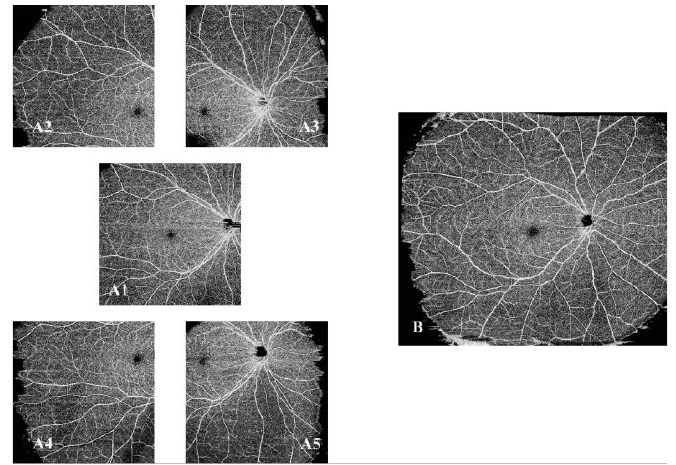
Figure 2. Swept source optical coherence tomography angiography (SS-OCTA) images of the right eye. ( A1 – A5 ) SS-OCTA images of 12 mm × 12 mm scanning mode in different regions. ( A1 ) Macula- centered. ( A2 ) Superior temporal. ( A3 ) Superior nasal. ( A4 ) Inferior temporal. ( A5 ) Inferior nasal. ( B ). The composite image of ( A1 – A5 ) with an area of 23.5 mm × 17.5 mm. SS-OCTA, swept-source optical coherence tomography angiography.